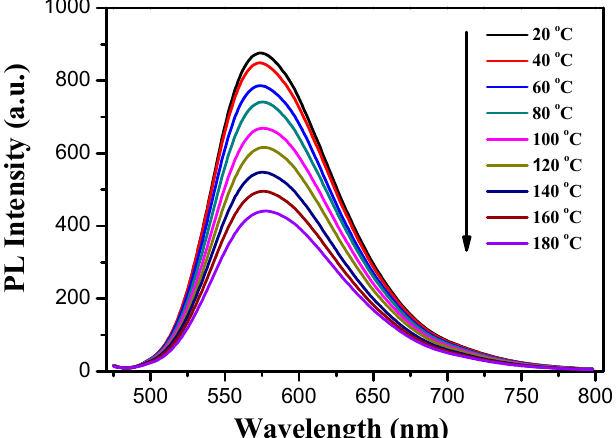
Figure 3. Temperature-dependent photoluminescence (PL) emission spectra of the polymer powders measured with increasing temperature from 20 to 180 °C, λ ex = 460 nm.